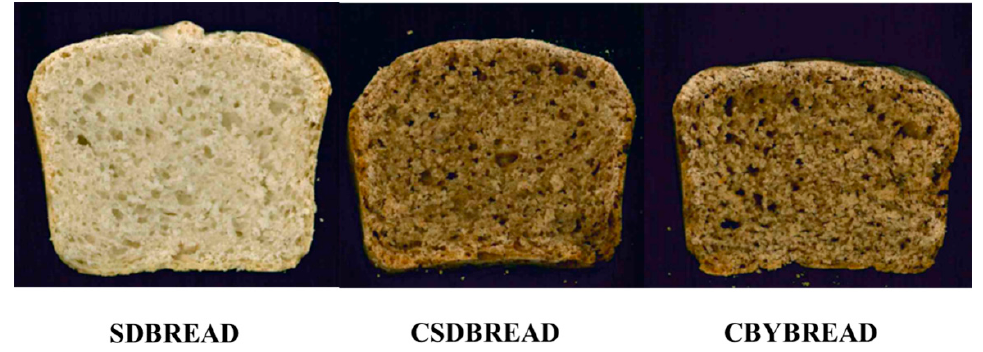
Figure 5. Slices obtained from the loaves of experimental breads.